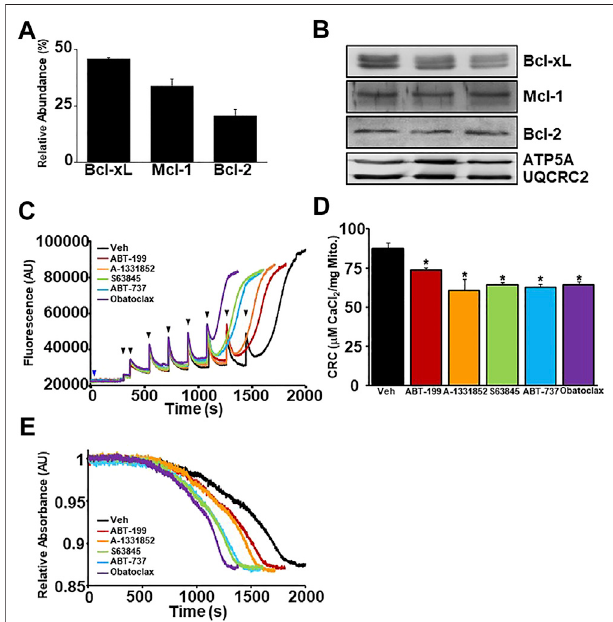
FIGURE 2 | BH3 mimetics decrease mitochondrial CRC and sensitize MPTP opening. (A) Quantitation of the relative abundance of anti-apoptotic Bcl-2 family members (Bcl-2, Bcl-xL, and Mcl-1) from enriched liver mitochondrial fractions isolated from mouse livers measured by tandem-mass-tagging mass spectrometry ( n (cid:2) 5). (B) Western blots for anti-apoptotic Bcl-2 (Bcl-2, Bcl-xL, and Mcl-1) and Ox. Phos. (ATP5A and UQCRC2) (loading control) using enriched mitochondrial lysates isolated from mouse livers. (C) Representative traces of mitochondrial calcium uptake of WTliver mitochondriatreated with either 200 nM ABT-199(red), 100 nM A-1331852 (orange), 10 nM S63845 (green), 100 nM ABT-737 (blue), 10 nM Obatoclax (purple), or with the vehicle control (black). The blue arrow represents the addition of the BH3 mimetics. The black arrowheads represent the addition of 20 μ M CaCl 2. (D) Quanti fi cation of mitochondrial calcium retention capacity (CRC) calculated from mitochondrial calcium uptake traces, as in (C) . (E) Representative trace of the corresponding mitochondrial swelling to (C) of WT liver mitochondria treated with BH3 mimetics and CaCl 2 . Three independent experiments ( n (cid:2) 3) were performed for every panel or otherwise noted.